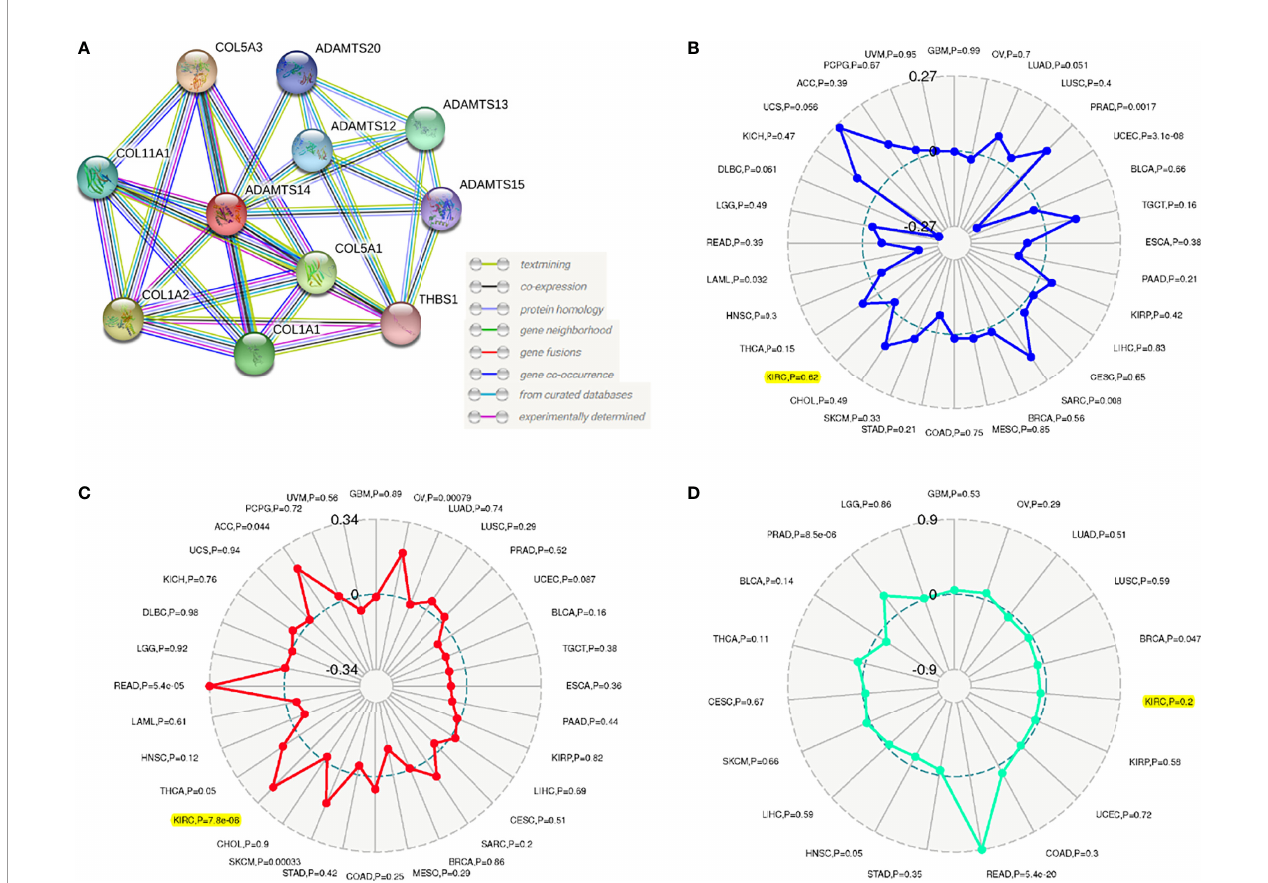
FIGURE 6 | Associations between ADAMTS14 and (A) PPI, (B) MSI, (C) TMB, and (D) TNB in TCGA dataset.